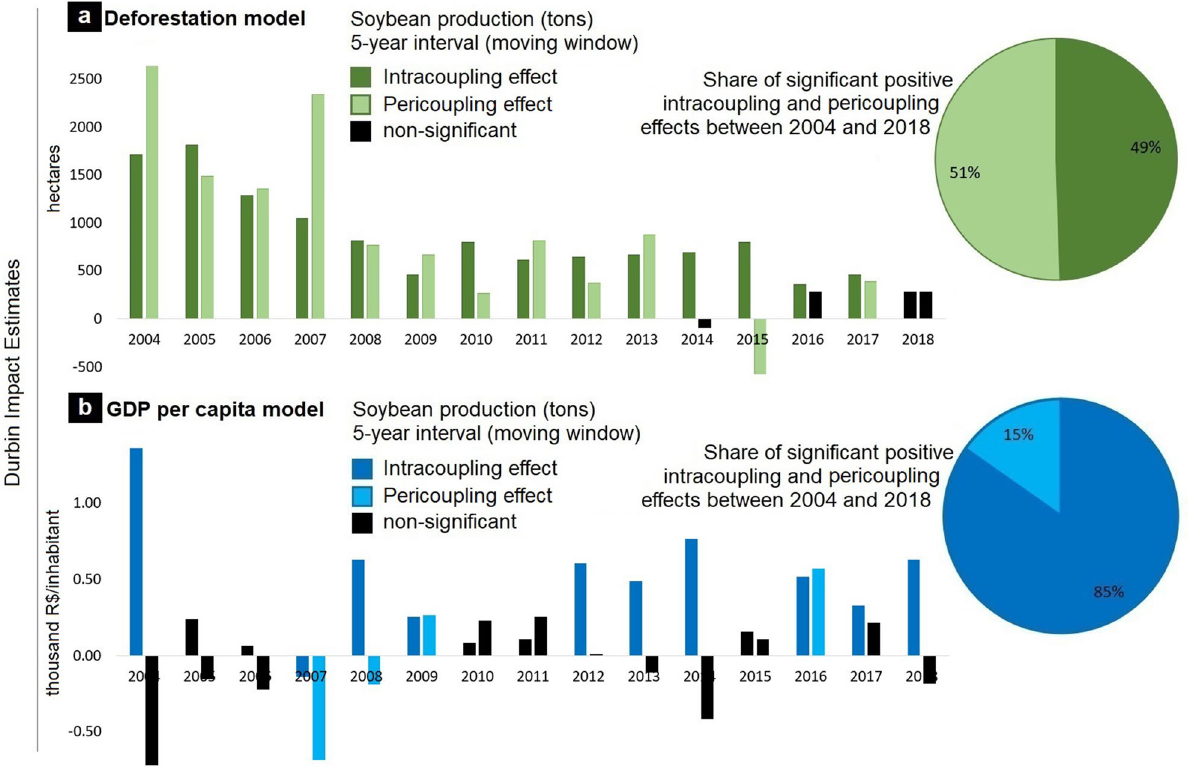
Figure 3. Results of spatial Durbin Error Models (SDEM) for fifteen subsets of model simulations between 2000 and 2018 using a moving window of five years. ( a ) SDEM to account for intracoupling and pericoupling effects of soybean production on deforestation across municipalities in the state of Mato Grosso, Brazil. ( b ) SDEM to account for intracoupling and pericoupling effects of soybean production on Gross Domestic Product (GDP) per capita across municipalities in the state of Mato Grosso,